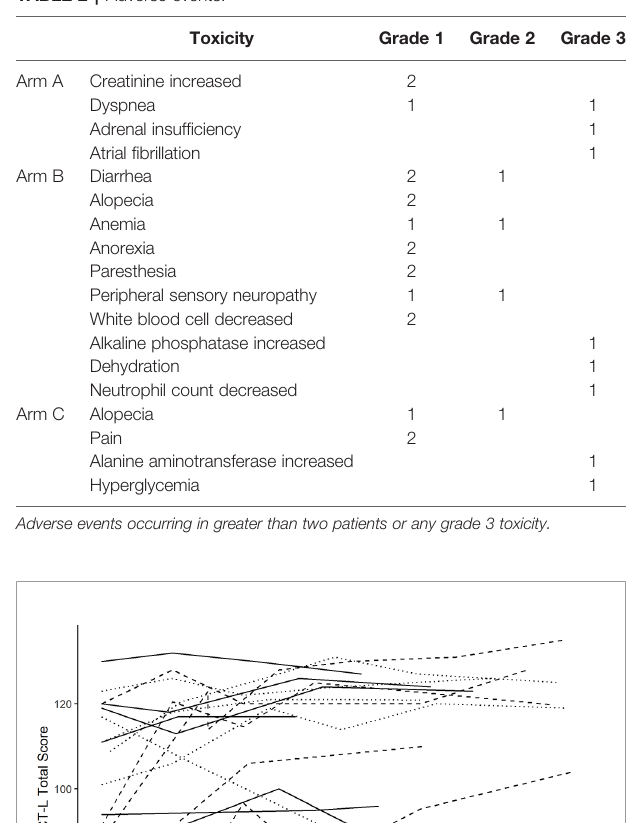
TABLE 2 | Adverse events.